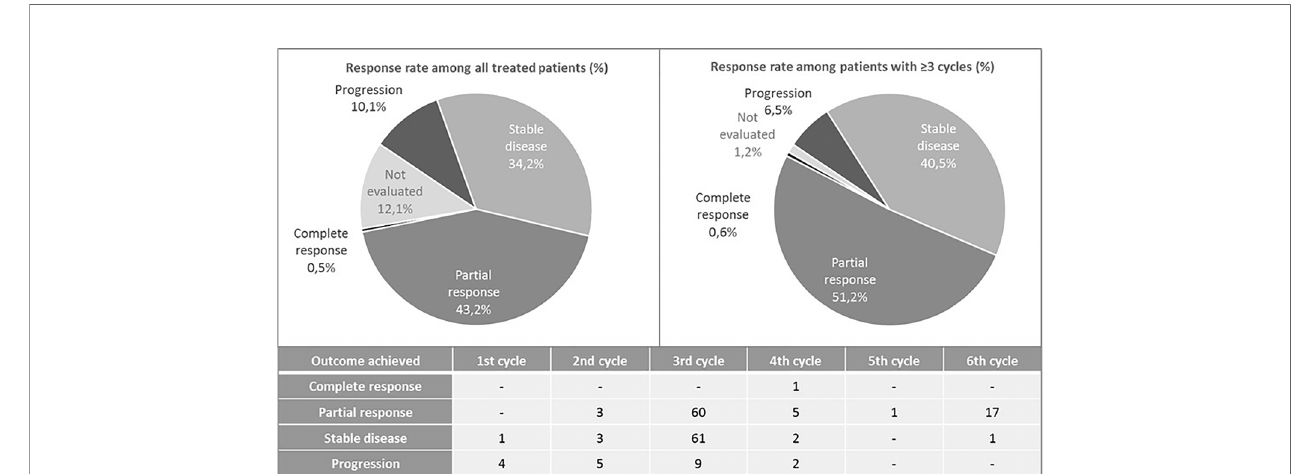
FIGURE 2 | Rate of responses to chemotherapy with carboplatin and paclitaxel combined with bevacizumab.